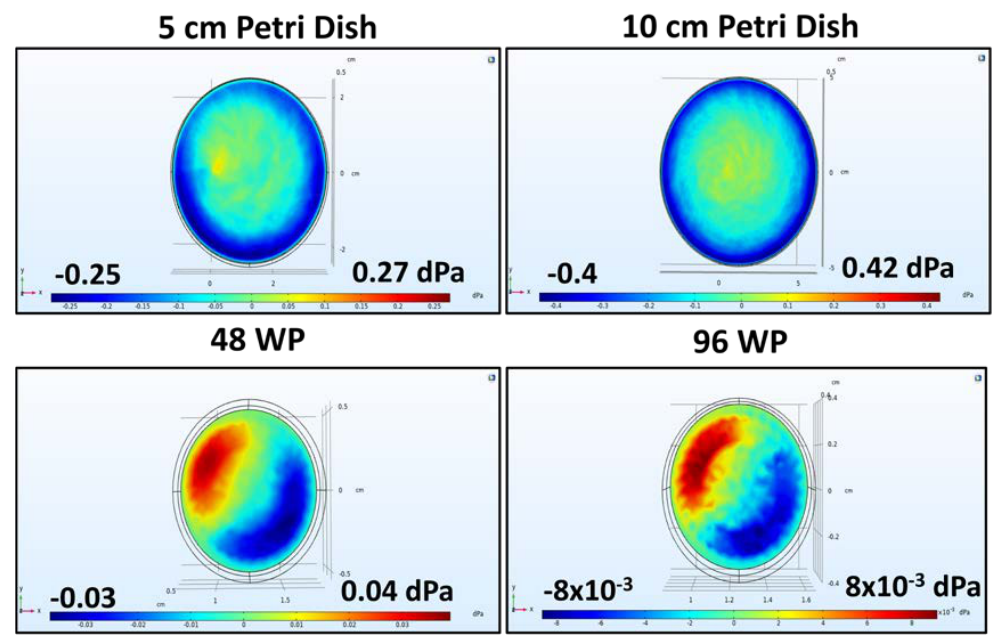
Figure 2. COMSOL simulations of fluid shear stress (FSS) in well plates (WPs) and Petri dishes at 100 rpm. Simulations using the Computational Fluid Dynamics (CFD) module show the tangential shear stress for 6, 12, 24, 48 and 96 WP as well as 5 and 10 cm Petri dishes. Maximum FSS values are reported for each.